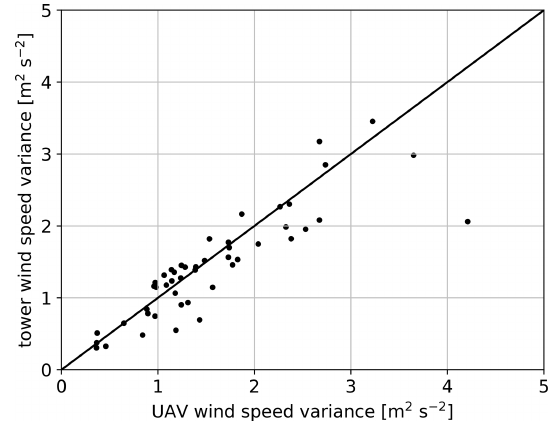
Figure 9. Variance of the wind speed for n = 34 flights in compari- son to sonic measurements at 50 and 90m